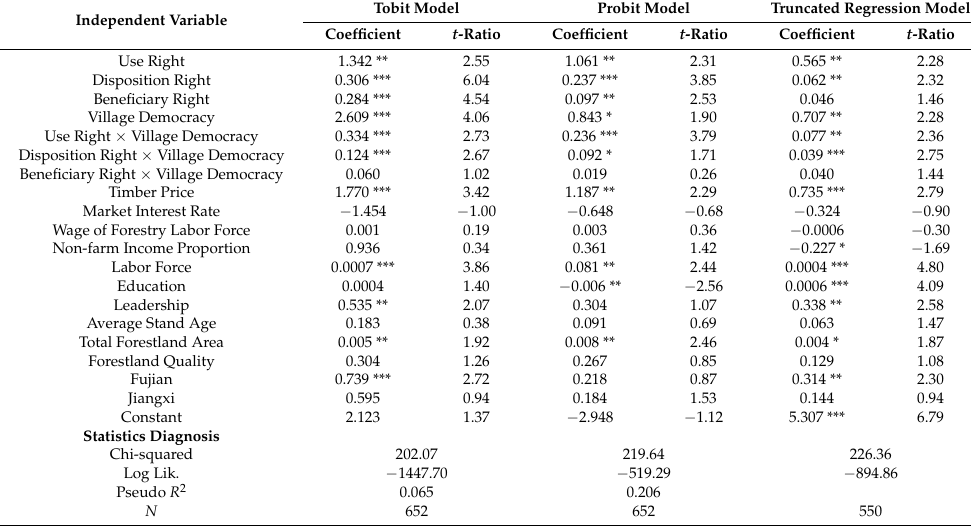
Table 3. Estimation results: Tobit and Cragg models for the probability and quantity of capital